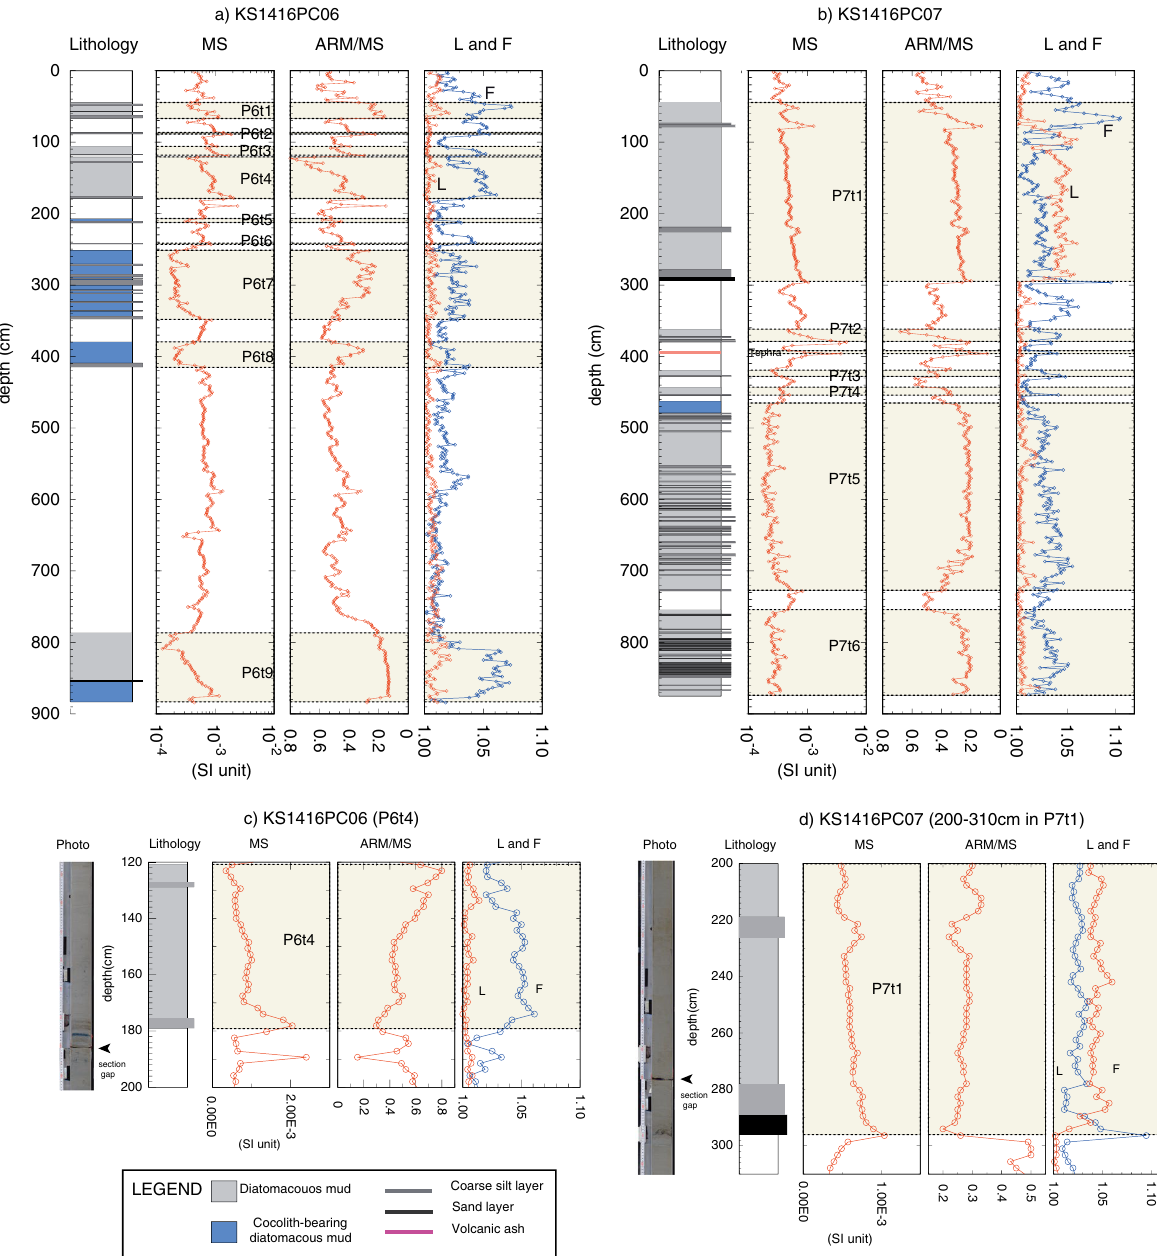
Fig. 2 Lithology and magnetic properties of core a KS1416PC06; b KS1416PC07; c photo, lithology, magnetic properties of turbidite of P6t4 in KS1416PC06; d photo, lithology, magnetic properties of turbidite of P7t1 in KS1416PC07. MS: magnetic susceptibility; ARM/MS: ratio of Anhysteretic remanent magnetization (ARM) and MS; L: magnetic lineation (red line); F: magnetic foliation (blue line). Lithology columns are based on Ikehara et al. (2017). Legend for lithological columns: white, bioturbated diatomaceous clay‑silty clay; gray, homogeneous diatomaceous clay‑silty clay; blue, homogeneous nannofossil‑bearing diatomaceous mud; red, volcanic ash; black thick line, sand bed; dark gray, coarse silt bed. Yellow hatches in MS, ARM/MS, L and F columns reveal the intervals of turbidite beds. The turbidite beds are labeled sequentially as P6t1 to P6t9 and P7t1 to P7t6. “P6” and “P7” stand for the core IDs “KS1416PC06” and “KS1416PC07.” “t” stands for turbidite, and “1” through “9” is the number of the turbidite deposit from the top to the base of the